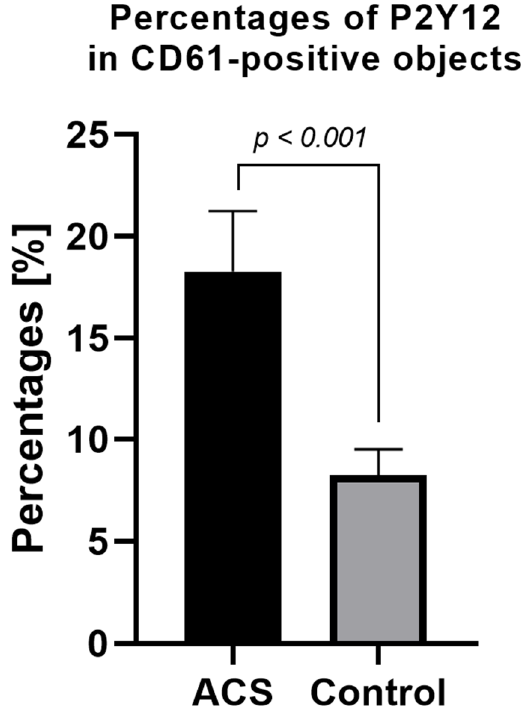
Figure 3. Platelet surface P2Y12 expression measured by flow cytometry method using PE Anti- Human P2Y12. Results presented in the figure show the percentage of P2Y12-positive targets in the population of CD61-positive subjects. Data are presented as a column bar graph with mean ± SD.